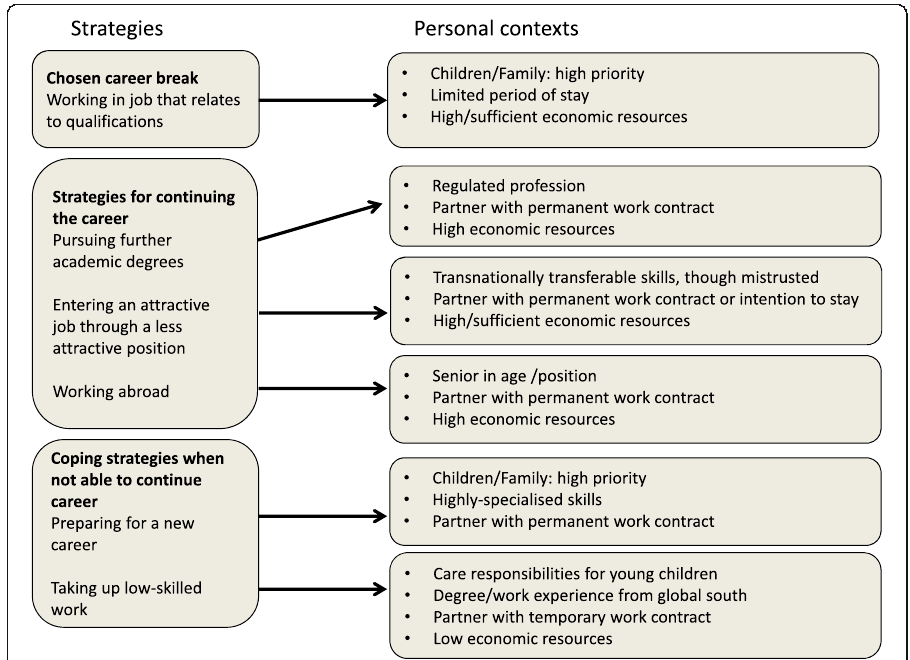
Fig. 2 Personal contexts for different strategies in the sample. Source: own